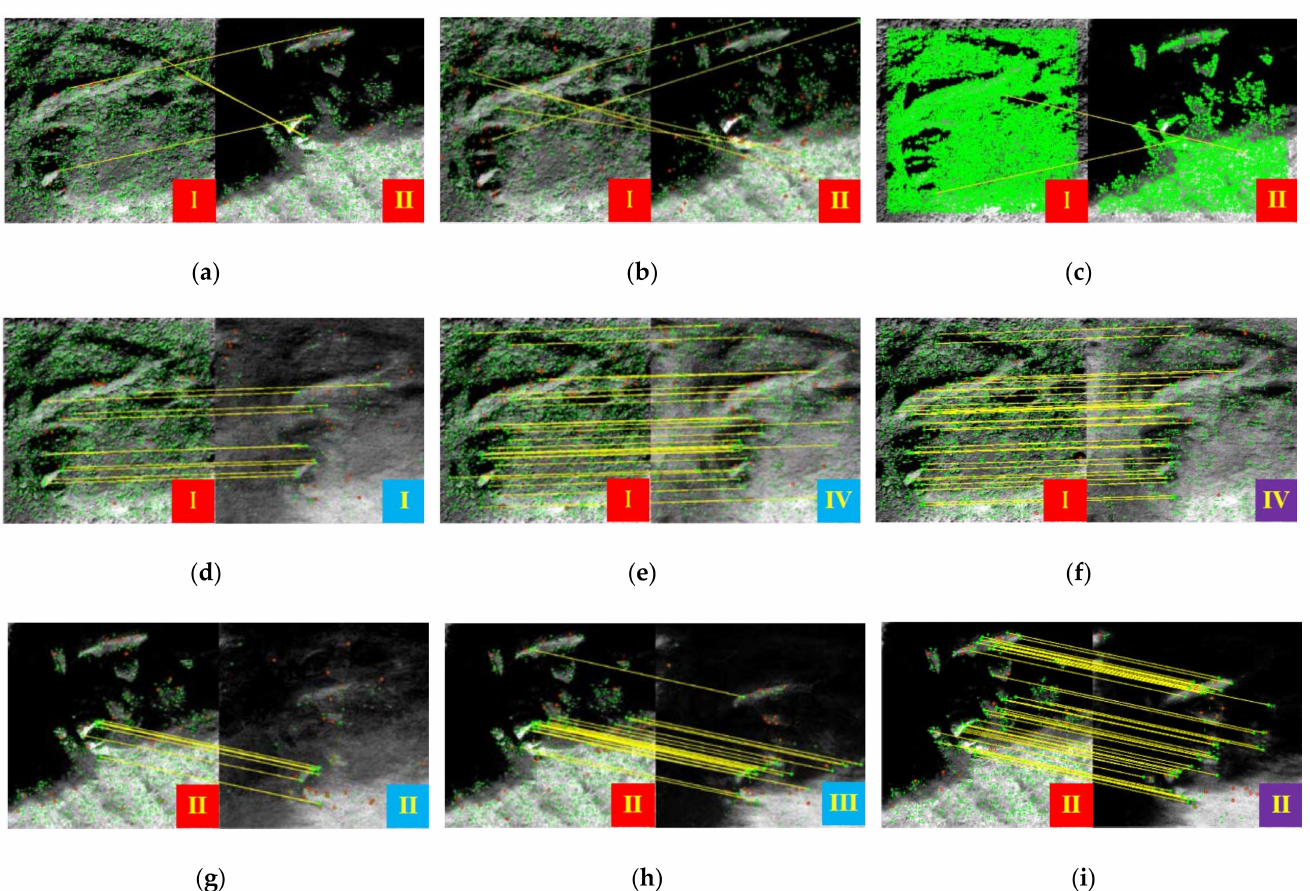
Figure 7. Feature extraction and matching results of local area image (600 × 650 pixels) and restored stable feature image of ecological reserve. The feature algorithms used are ( a ) SURF, ( b ) SIFT, ( c ) ORB, and ( d – i ) SURF. The roman numeral in the lower right corner is the image number, which corresponds to the image with the same number and background color in Figure 6. The green cross represents the detected key points, the red circle represents the filtered outer points, and the green circle and its associated yellow connecting line are the reserved inner point